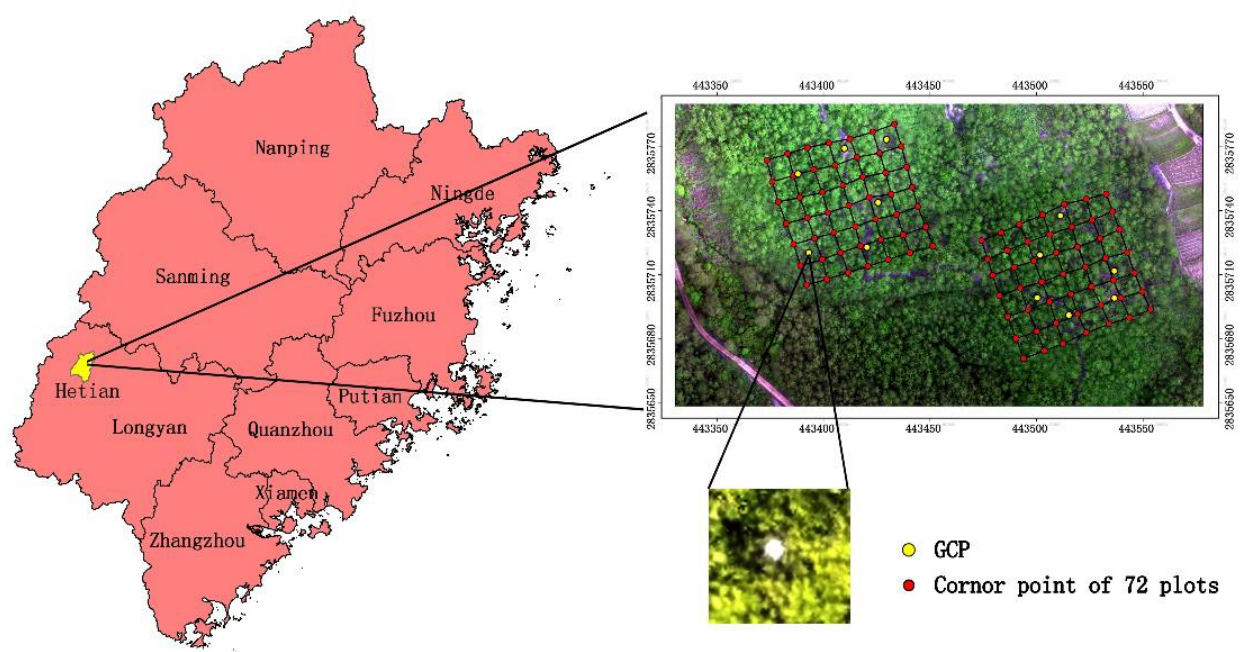
Figure 1. Distribution of sample plots.